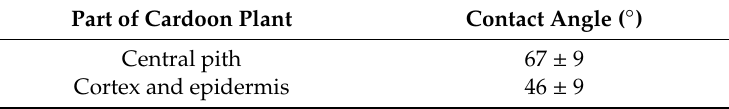
Table 1. Contact angle of di ff erent parts of the cardoon